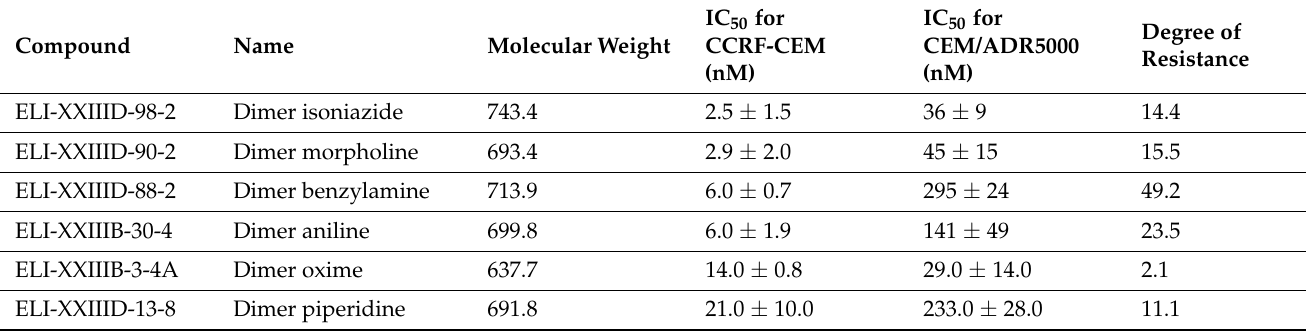
Table 1. Molecular weights and IC 50 values of wild-type, drug-sensitive CCRF-CEM and